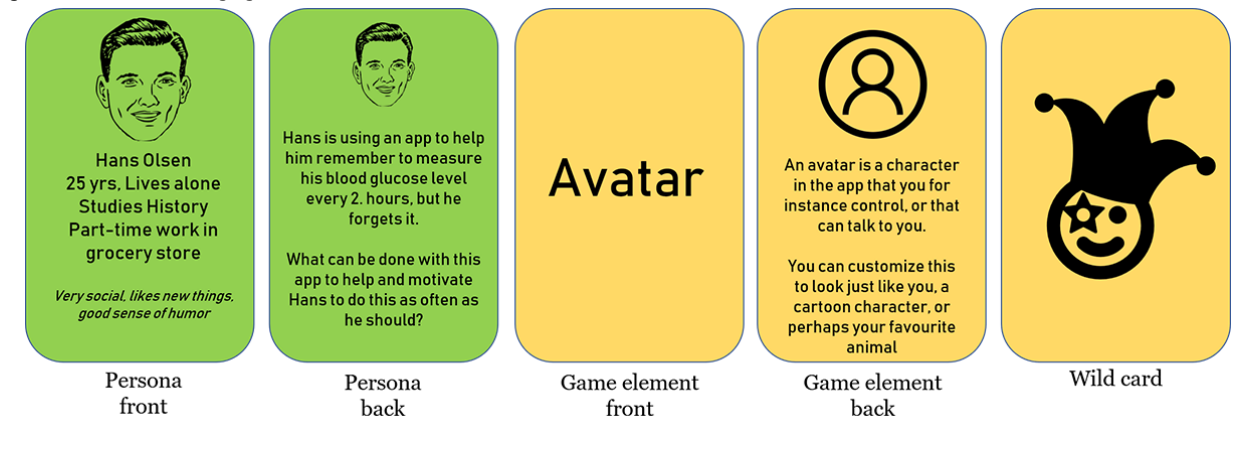
Figure 3. Posters for design